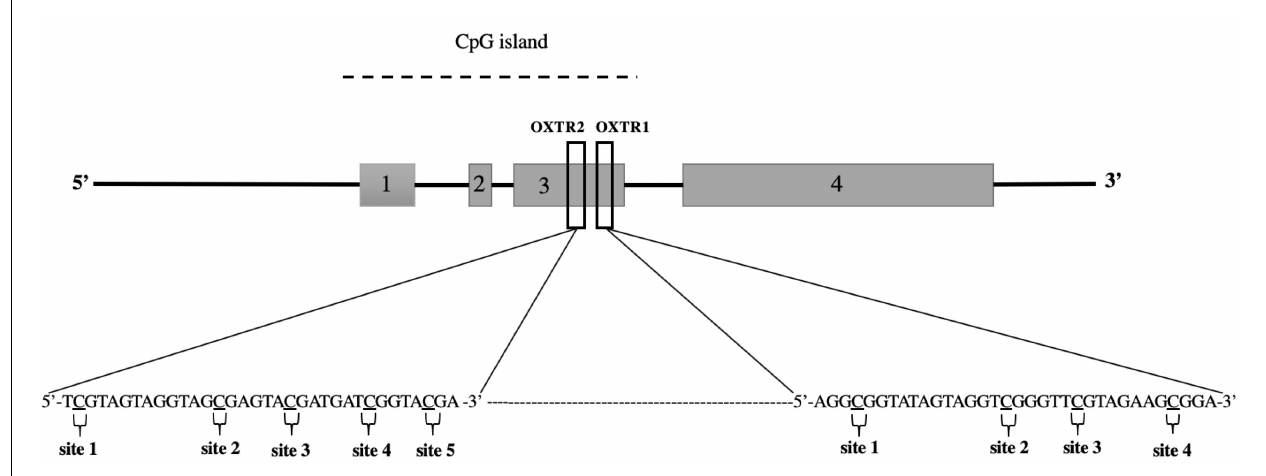
FIGURE 1 | Schematic view of the oxytocin receptor gene ( OXTR ) located at chromosome 3p25, nt 8,809,533–8,809,566. CpG sites within the target sequence analyzed after sequencing are underlined and numbered consecutively. Sites 1–9 indicate the CpG position analyzed by commercial assays, OXTR1 (PM00016821) and OXTR2